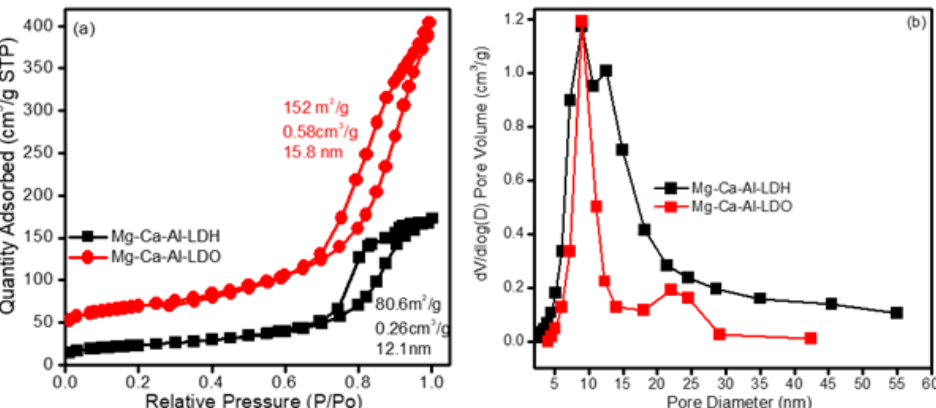
Figure 1. N 2 adsorption/desorption isotherm ( a ) and pore size distribution of Mg-Ca-Al material ( b ).